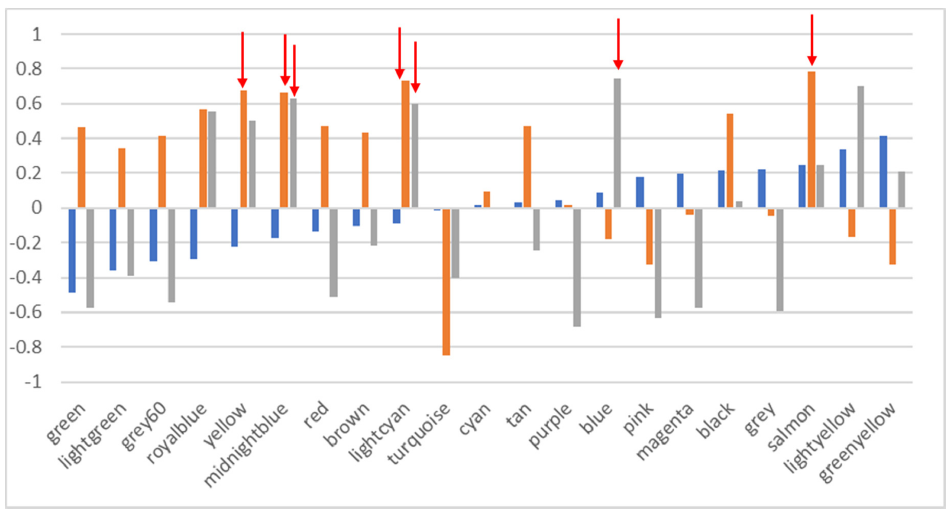
Figure 5. Correlation (y-axis) in the geographical distribution between WGCNA phylogenetic modules and functional WGCNA modules. The three columns represent the correlation coefficient for each of the three phylogenetic modules (Blue: PHYLO1; Orange: PHYLO2; Grey: PHYLO3) with the functional modules on the y-axis. Red arrows highlight the correlations that are significant.